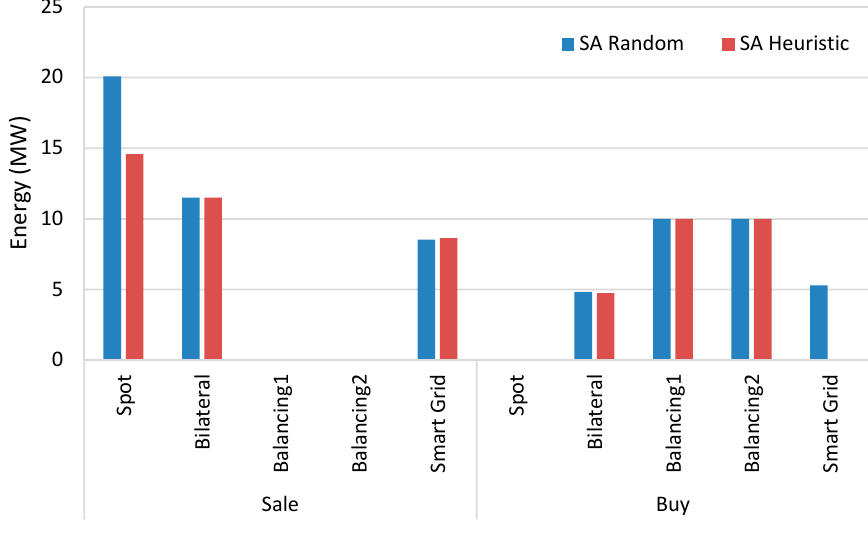
Figure 6. Purchase and the sale in different markets.